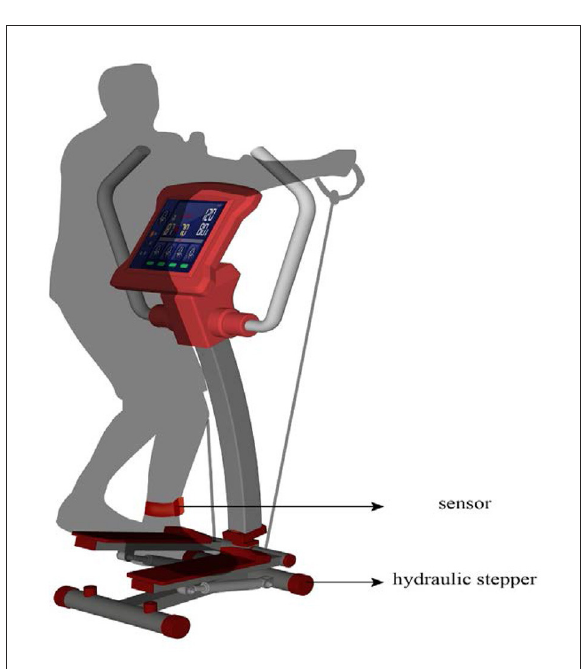
FIGURE8 Hydraulic stepper for CMEC